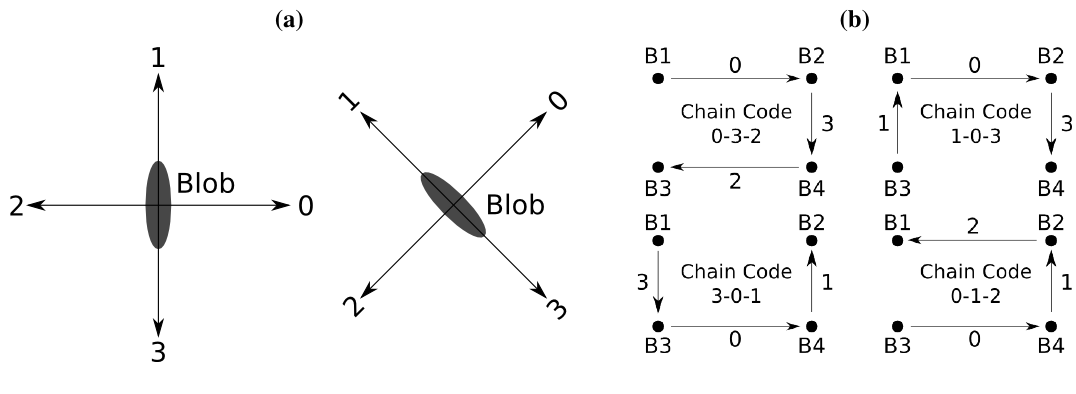
Figure 10. ( a ) Displacement codes of the chain code. We calculate the displacements with respect to the blob coordinates: invariance on rotations lower than ± 90 ◦ . ( b ) Examples of chain codes of a set of four points. Not all possible chain codes are